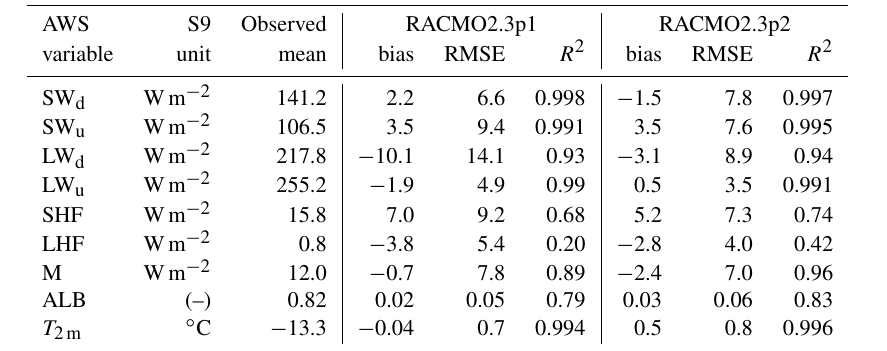
Table 4. Modelled and observed mean SEB components and statistics of the differences (2009–2015) at station S9 close to the equilibrium line (1520ma.s.l.). Statistics include means of measurements collected at S9, model bias (RACMO2.3pX – observations), RMSE of the bias as well as the determination coefficient of monthly mean data. All fluxes are set to positive.